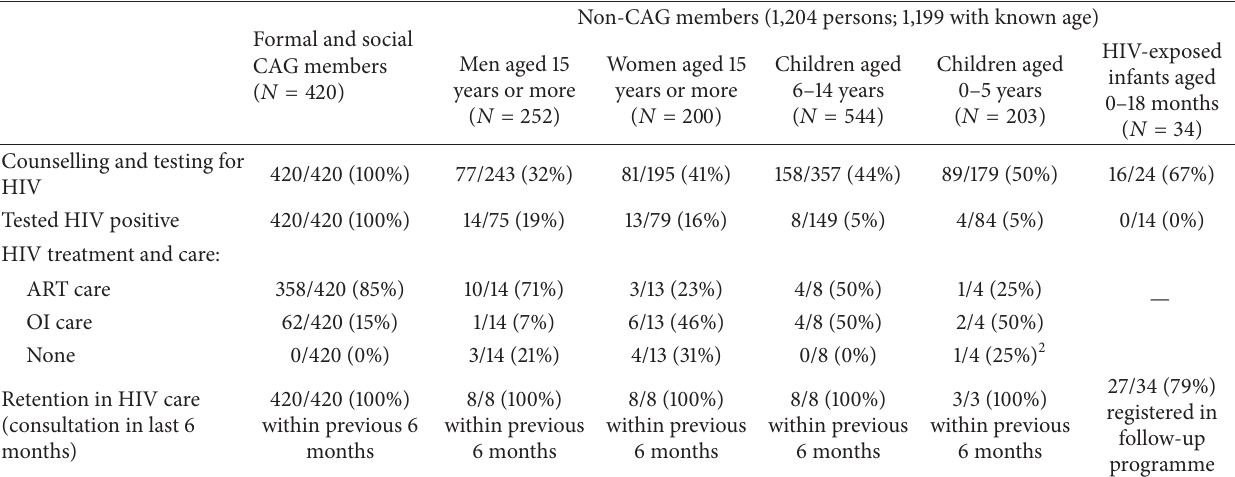
Table 2: Utilization of HIV services.